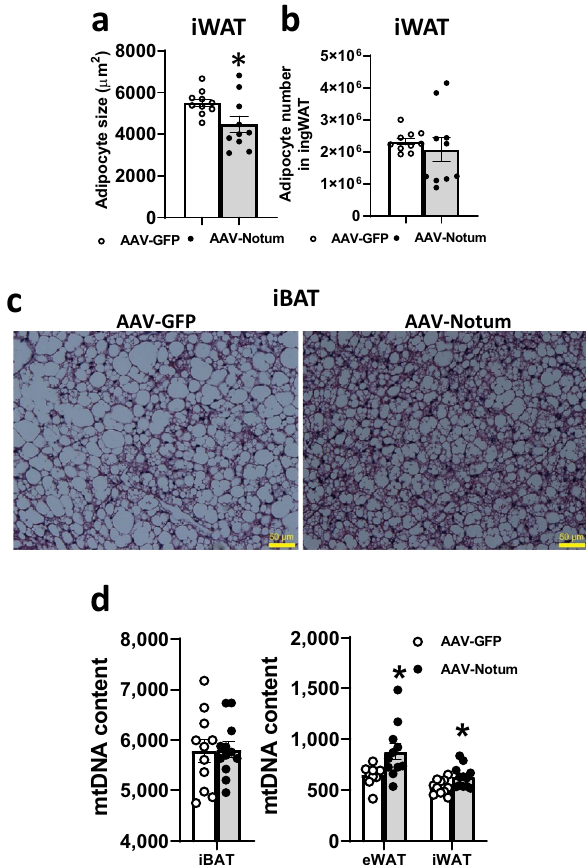
Figure 5. NOTUM overexpression decreases adipocyte hypertrophy in iWAT, preserves BAT morphology, and increases mitochondrial DNA content in WATs. Tissue samples were from mice described in Fig. 1a–j. Average adipocyte size, ( a ) and total adipocyte number, ( b ) of iWAT were determined as described in the “Material and methods” section. n = 10 per group. ( c ) Representative H&E stained histological sections of iBAT are shown. ( d ) Mitochondrial DNA (mtDNA) contents of eWAT, iWAT, and iBAT are shown (n = 9–12). Symbols:*: p < 0.05, AAV-GFP versus AAV-Notum, as determined by Student’s